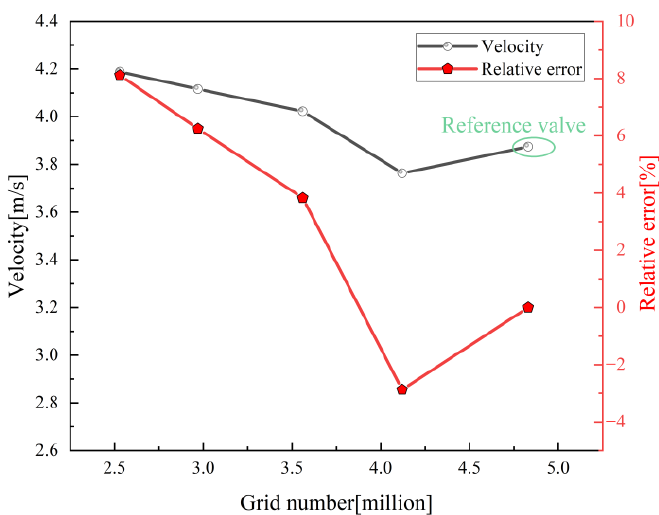
Figure 4. Grid independence analysis.